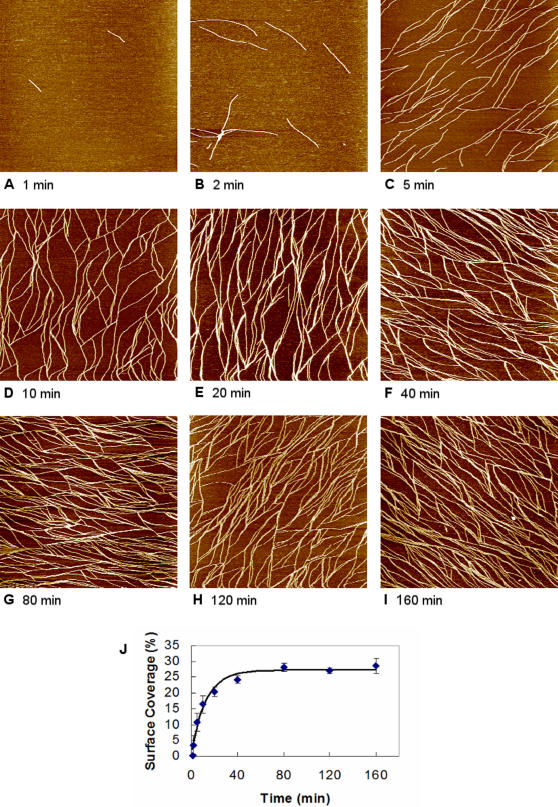
Time evolution of 4 µM EAK16-II assembly on the mica surface.AFM images collected at various incubation times: (a) 1 min; (b) 2 min; (c) 5 min; (d) 10 min; (e) 20 min; (f) 40 min; (g) 80 min; (h) 120 min; (i) 160 min. Surface coverage of EAK16-II on mica as a function of incubation time is plotted in panel (j). Each image corresponds to a scan area of 2000 nm×2000 nm.